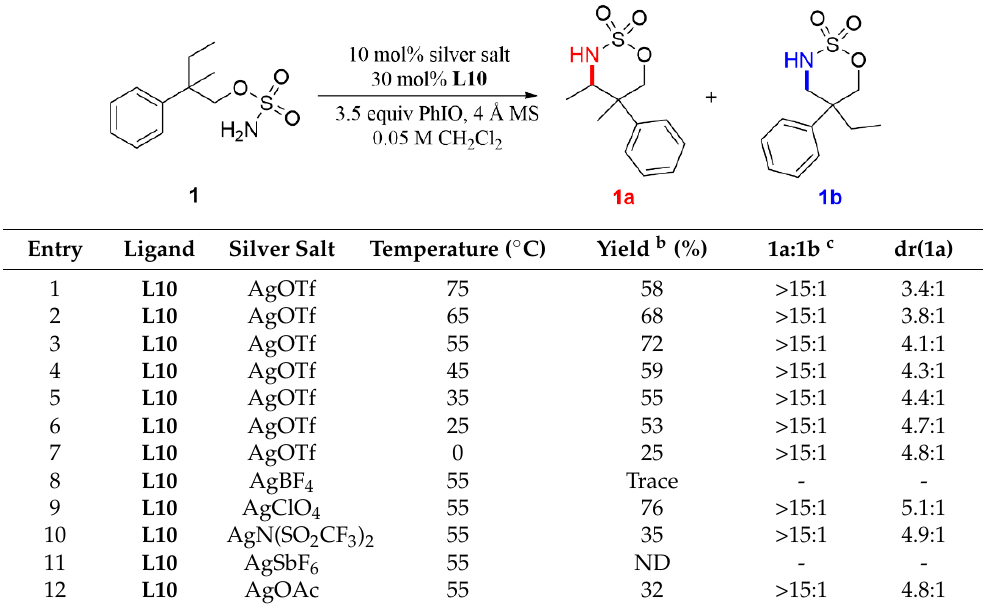
Molecules 2022 , 27 , x FOR PEER REVIEW 5 of 15